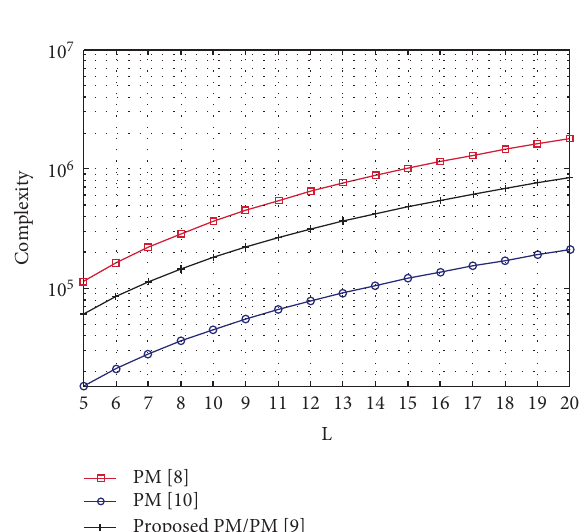
Figure 5: Complexity versus the number of sensors.